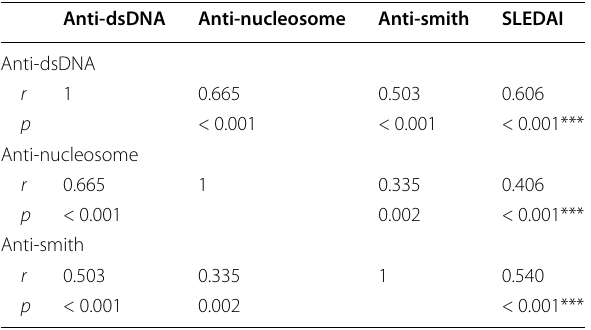
Table 5 Correlations between the three autoantibodies and the SLEDAI score